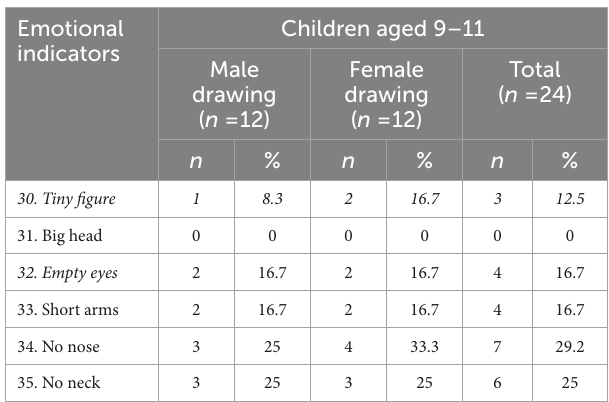
TABLE 6 Frequencies of emotional indicators from age 9 in Two Human Figure test (T2F).